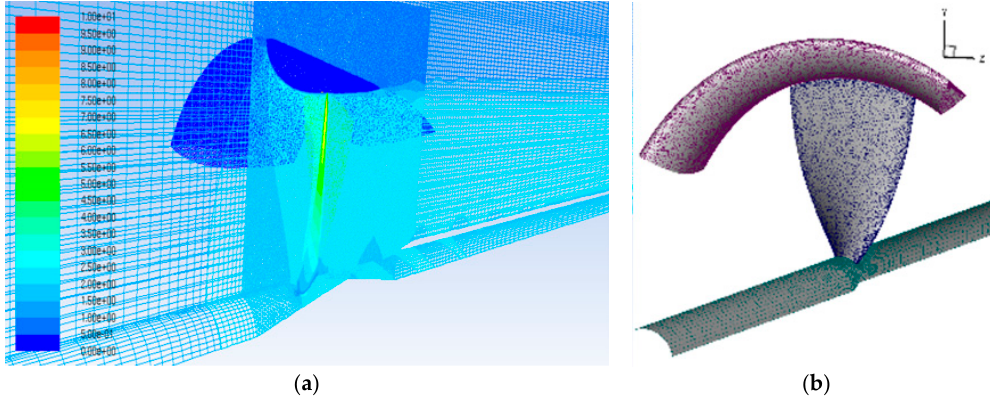
Figure 11. Gridding of blade, hub, and duct surface in RANS simulation ( b ), and the x – y plane passing through the propeller axis ( a ). The scale shows the vorticity in s − 1 .